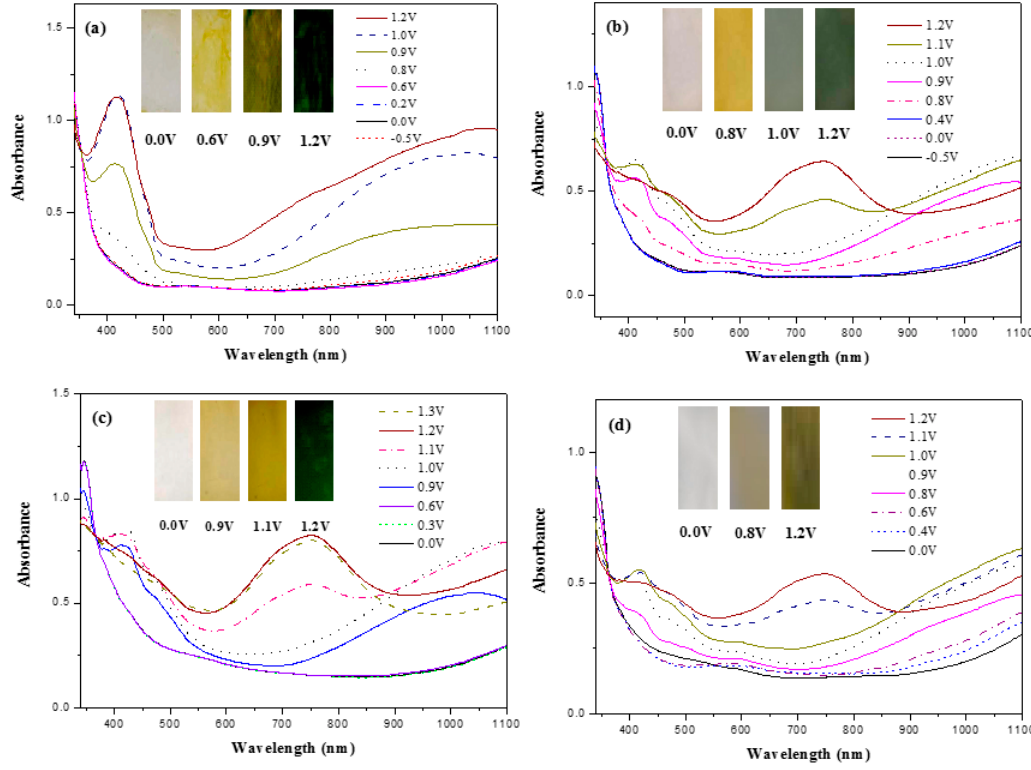
UV–Visible spectra of: ( a ) PBCz; ( b ) P(BCz- co -EDOT); ( c ) P(BCz- co -ProDOT); and ( d ) P(BCz- co -EDTT) on ITO in a PC/ACN (1:1, by volume) solution containing 0.2 M LiClO 4 .